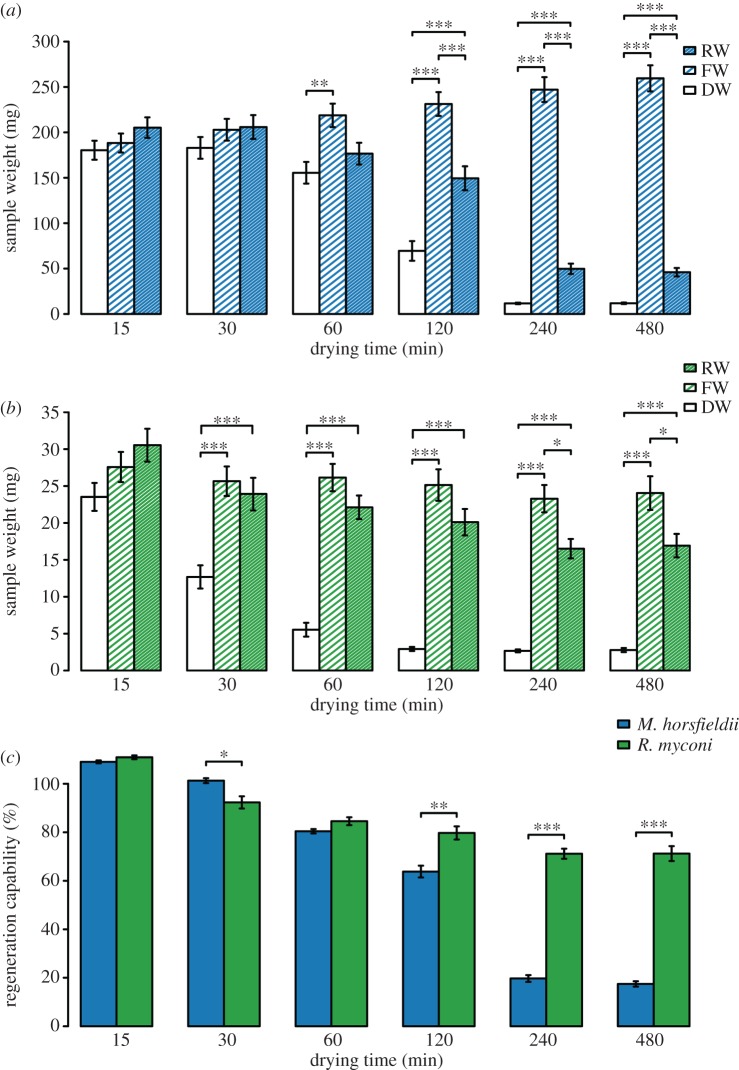
Comparison of the regeneration capacities of M. horsfieldii hypocotyl and R. myconi leaf stalk segments after different drying durations. (a,b) The regeneration capability of M. horsfieldii hypocotyl segments is considerably less than that of R. myconi leaf stalk segments after different drying durations. (c) Comparisons of M. horsfieldii and R. myconi regeneration capacities after different drying durations indicate different amounts of passively functioning adaptations. Values are given as means ± standard errors; N = 10; *p < 0.05; **p < 0.01; ***p < 0.001; DW, dry weight; FW, fresh weight; RW, rehydrated weight.